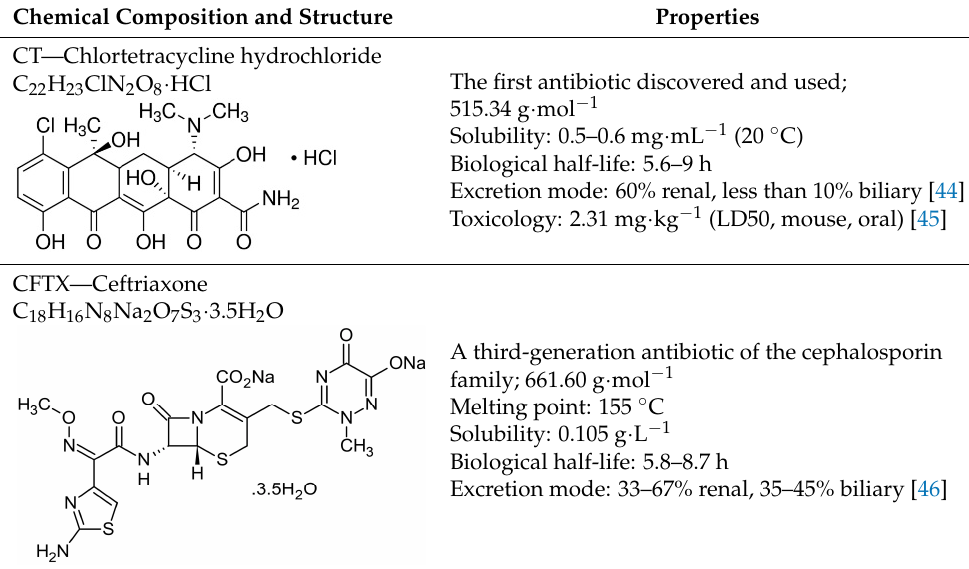
Table 1. Chemical structure and some characteristics of antibiotics.